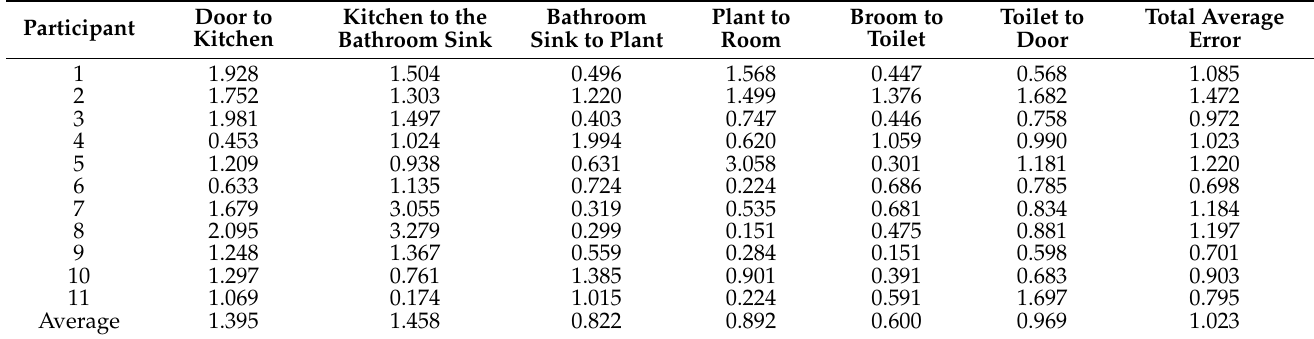
Table 6. Average error (in meters) of the location for each sub-trajectory (older adults’ group).